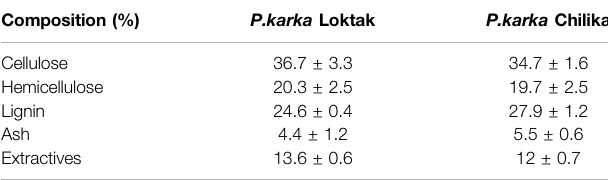
TABLE 1 | Composition of Phragmites collected from Loktak Lake and Chilika Lake. Composition